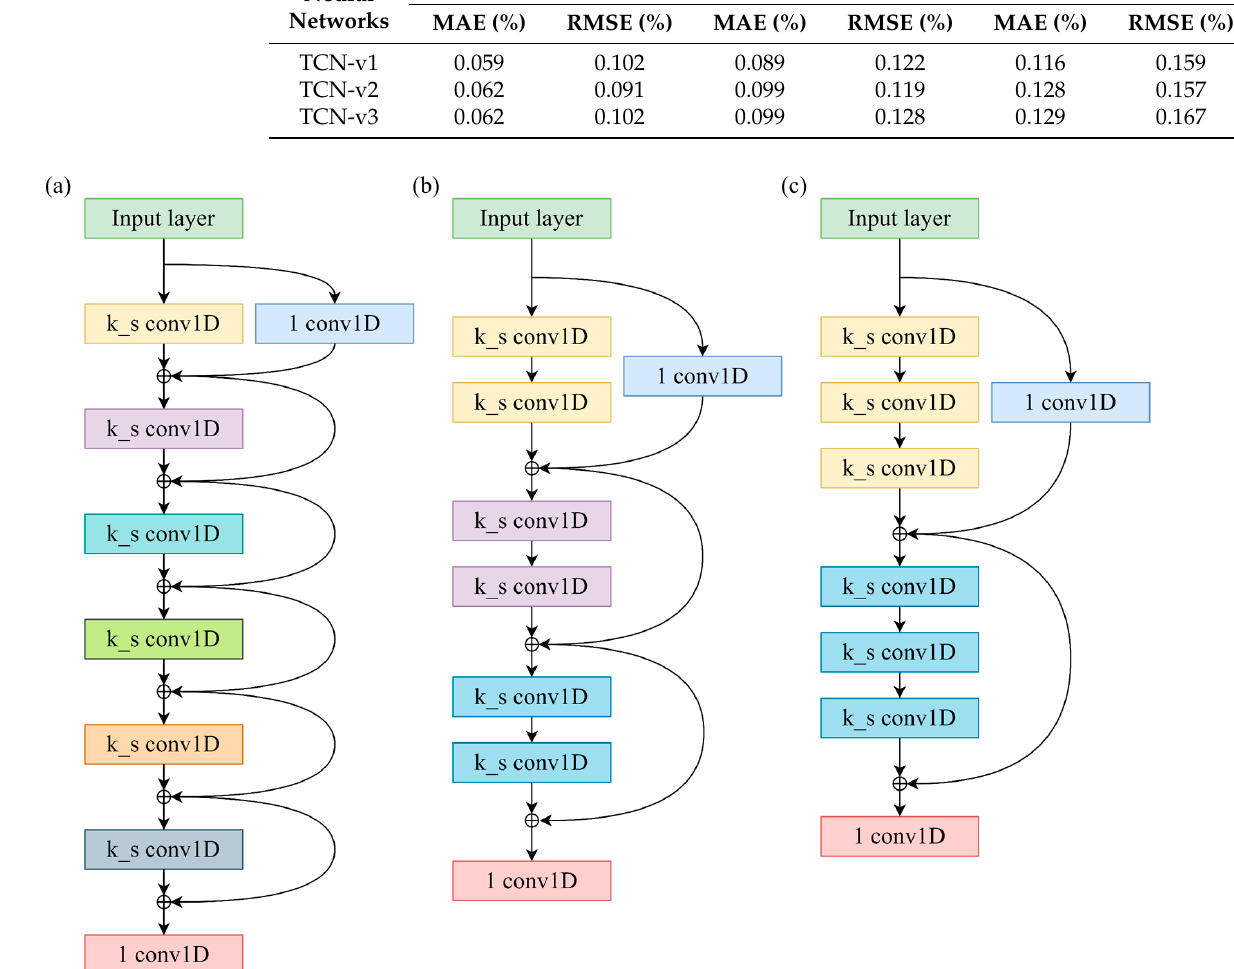
Figure 7. Architectures of TCN for SOC estimation: ( a ) TCN-v1; ( b ) TCN-v2; ( c ) TCN-v3. Table 2. The SOC estimation performance for ICR18650 under 25 °C based on the three kinds of